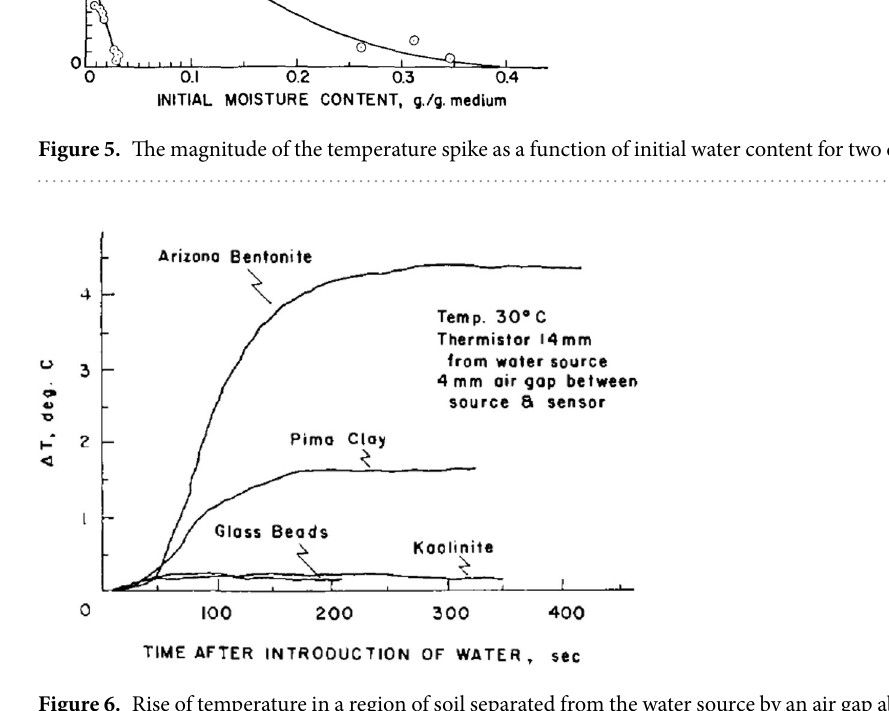
the air gap under the small hydraulic head they employed. The resulting temperature-time curves for Arizona bentonite are shown in Fig. 6. A temperature rises similar to the one shown in Fig. 4 above was found, but there was no drop in the temperature anymore. Anderson and Linville 8 concluded that the rise of temperature must have been due to the condensation of water vapor that had crossed the gap. Measurement of moisture content of the medium across the gap showed a significant increase. They could confirm that the liquid water did not cross the air gap by visual inspection after the data was recorded. In experiments by Anderson and coworkers, water flow was downward. So, the flow was not only due to spon- taneous imbibition but it was also gravity driven. Horizontal water infiltration experiments, with water flow due to spontaneous imbibition only, were performed by Perrier and Prakash 9 . Also, they measured not only tempera- ture but also air humidity in the soil. They prepared two columns, both filled with Flanagan silt loam; air dried for one column and oven dried for the other column. Typical results are shown in Fig. 7. As with earlier experiments, the temperature rose as the water approached a given position, and decreased after the passage of the front. But, contrary to experiments of Anderson and coworkers, it stayed above the original temperature of the column. Also, the magnitude of the spike became smaller with increasing distance along the column. Measurements of relative humidity transducers showed that the air humidity increased almost instantane- ously from background value to 100% relative humidity (see Fig. 8). It is clear that the temperature starts to rise much earlier than the rise of the air humidity. Perrier and Prakash 9 considered the first inflection point of the temperature profile as the position of temperature front. Because the horizontal column was made of Lucite, they could also follow the macroscopic liquid water front. They observed that the thermal peak (site of greatest tem- perature gradient) coincided exactly with the position of the liquid front. “ Consequently ,” they wrote, “ the thermal peak was taken to be the location of the liquid front for the data presented .” A plot of the locations of three fronts as a function of time is shown in Fig. 9. It is evident that the vapor front arrived only slightly ahead of the water front.